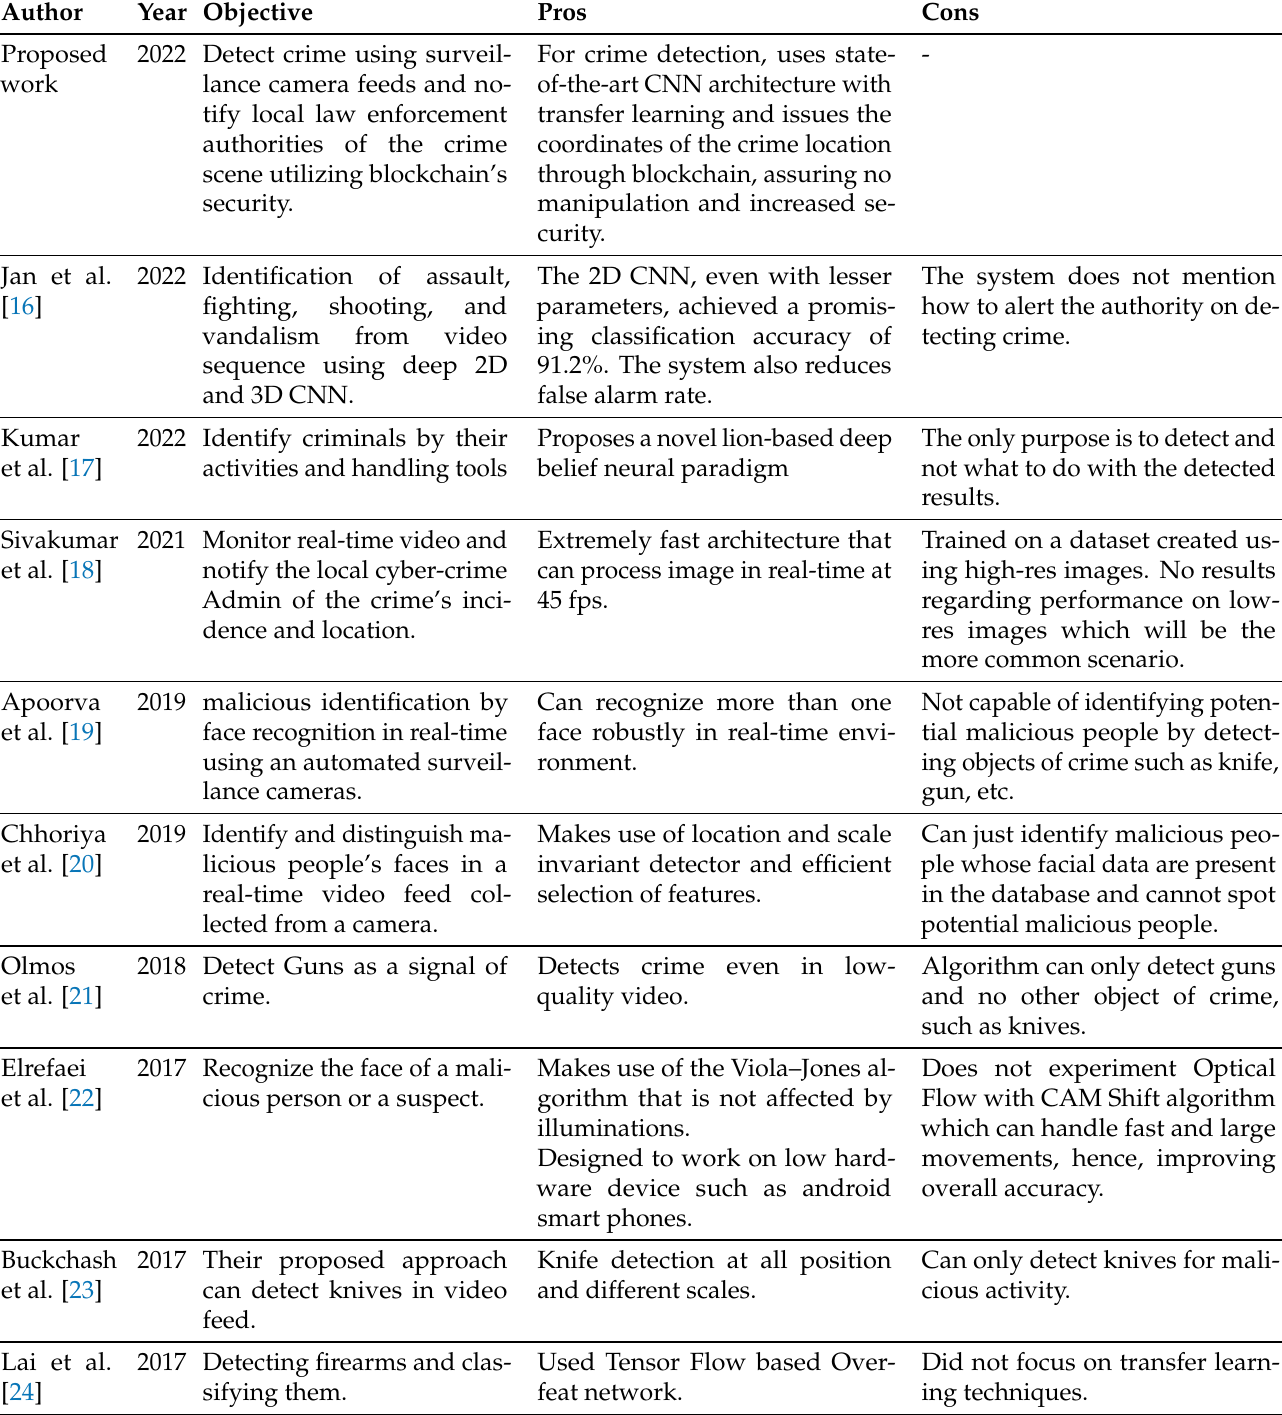
Table 1. Relative comparison of the proposed approach with various state-of-the-art approaches in crime detection for public